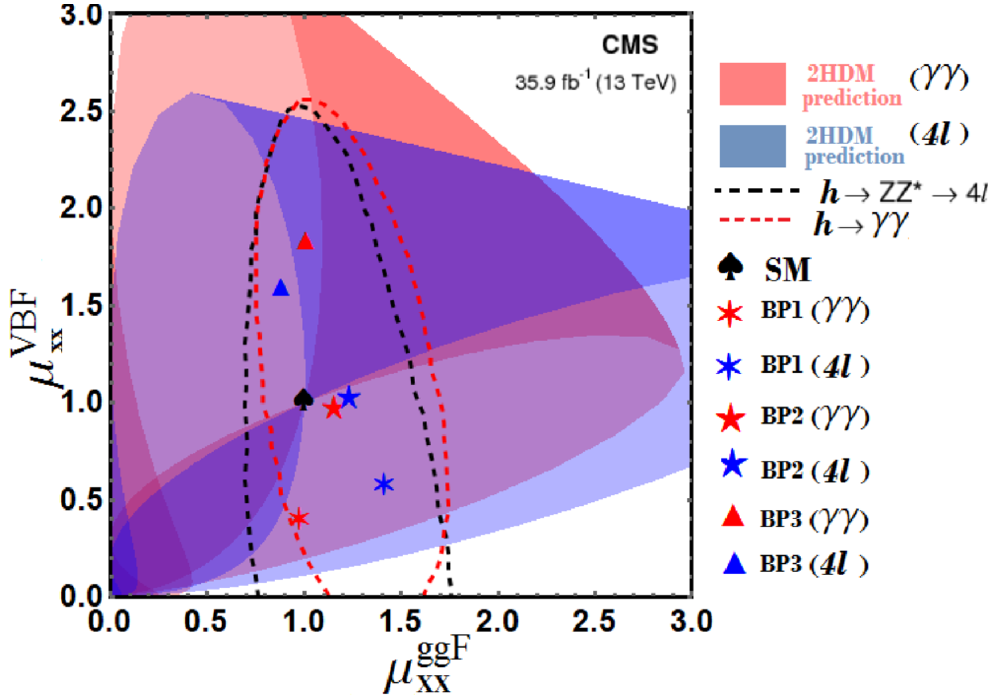
Figure 9 . The two-dimensional best-(cid:12)t of the signal strengths for ggF and VBF production modes compared to the SM expectations (black spade) looking at h ! (cid:13)(cid:13) [53, 54] and h ! ZZ ? ! 4 l [59, 60] channels. The dashed red and black line represent the 2 (cid:27) standard deviation con(cid:12)dence region for h ! (cid:13)(cid:13) [53, 54] and h ! ZZ ? ! 4 l [59, 60] channels respectively. Red and blue shaded regions are 2HDM predicted region. Three benchmark points (BP) are also shown in this contour plot. includes such e(cid:11)ects, as we allow both signs for ~ Y . Using scans over the full b